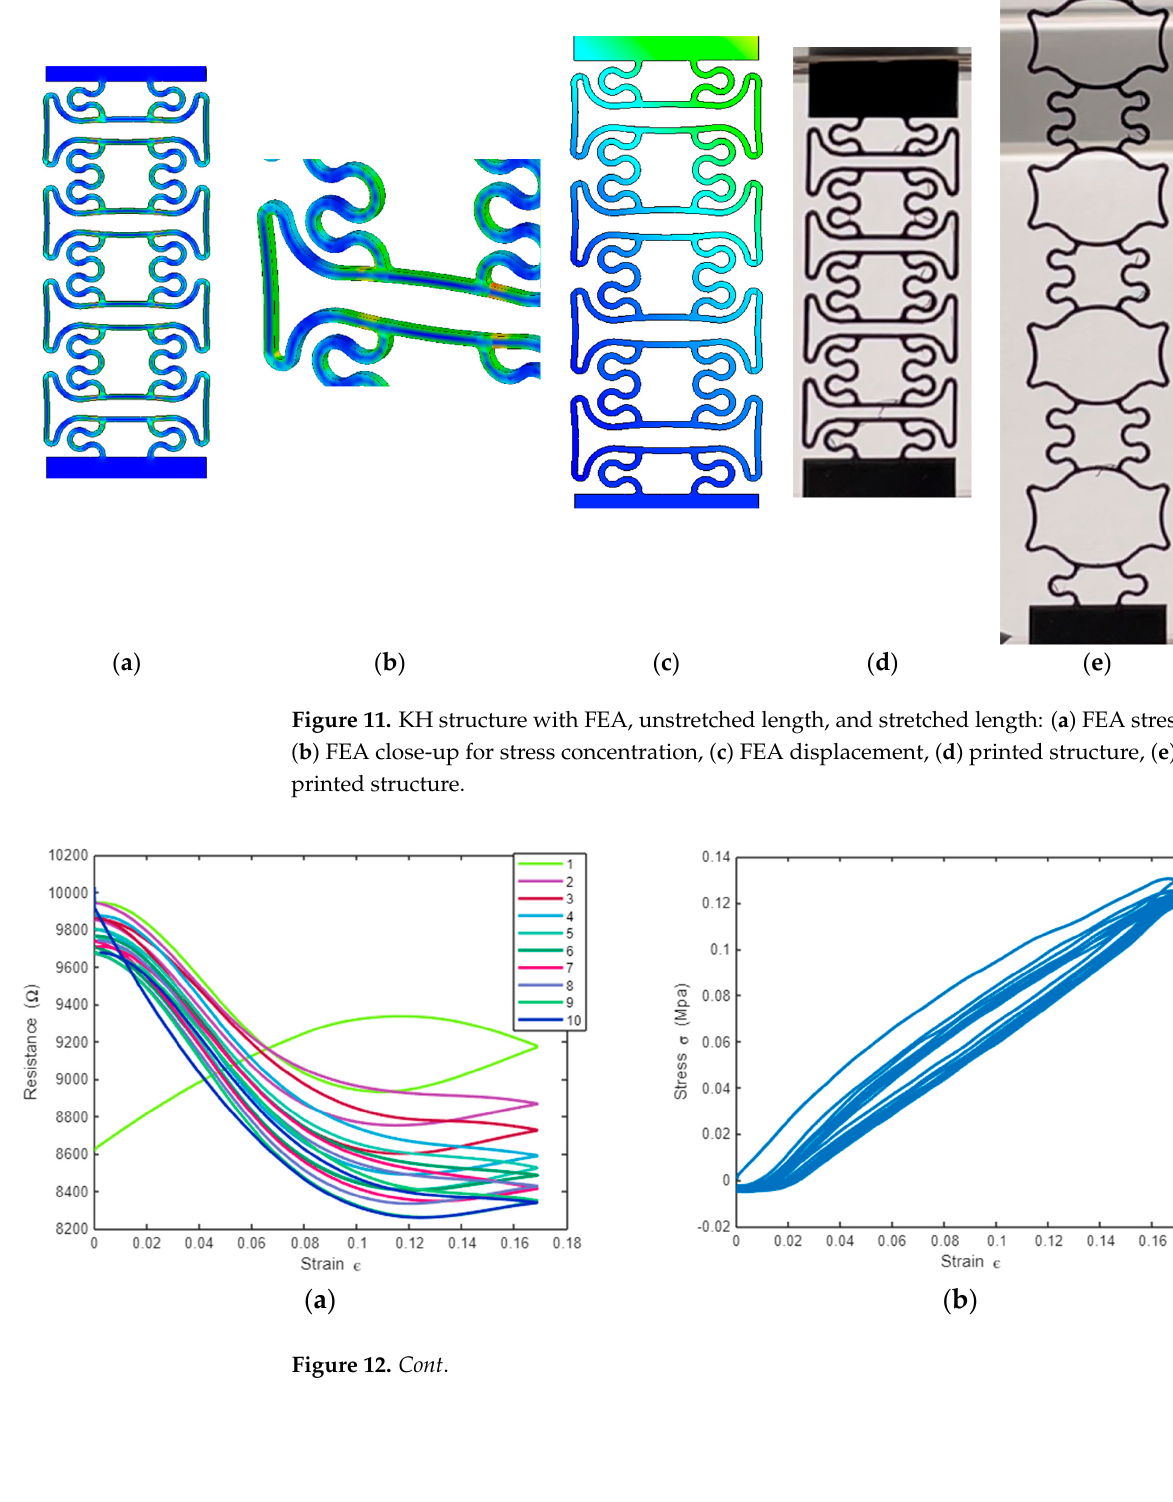
Figure 11. KH structure with FEA, unstretched length, and stretched length: ( a ) FEA stress analysis, ( b ) FEA close-up for stress concentration, ( c ) FEA displacement, ( d ) printed structure, ( e ) stretched printed structure.